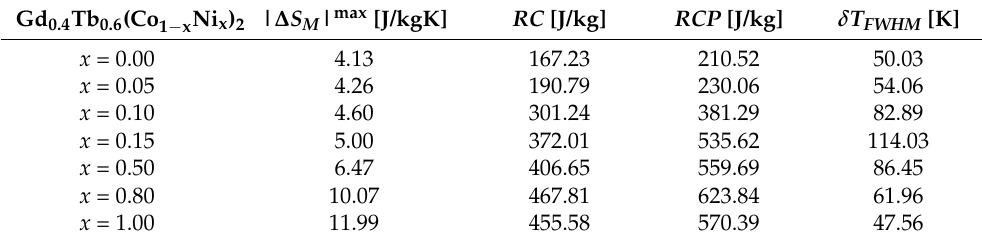
Figure 9. Magnetic entropy changes − ∆ S M as a function of temperature for samples with x = 0.00 ( a ), 0.05 ( b ), 0.10 ( c ), 0.15 ( d ), 0.50 ( e ), 0.80 ( f ), 1.00 ( g ). Variation of the maximum of the entropy changes | ∆ S M | max with the growth of a magnetic field ( h ). Table 3. The maximum of the entropy changes | ∆ S M | max , RC , RCP, and δ T FWHM parameters as a function of x in Gd 0.4 Tb 0.6 (Co 1 − x Ni x ) 2 compounds. All data are for the magnetic field of 5 T.